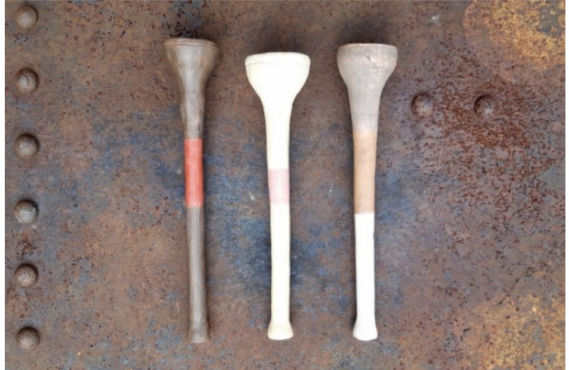
Figure 16. Ceramic trumpets. Experimental models by Friedemann Schmidt (2010) and Osvaldo Padr ó n (2019–2020), length: 26.0–30.5